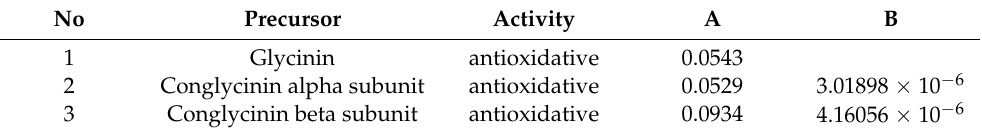
Table 1. Profile of biological activity as an antioxidative peptide of glycinin and to the β and α subunits of β